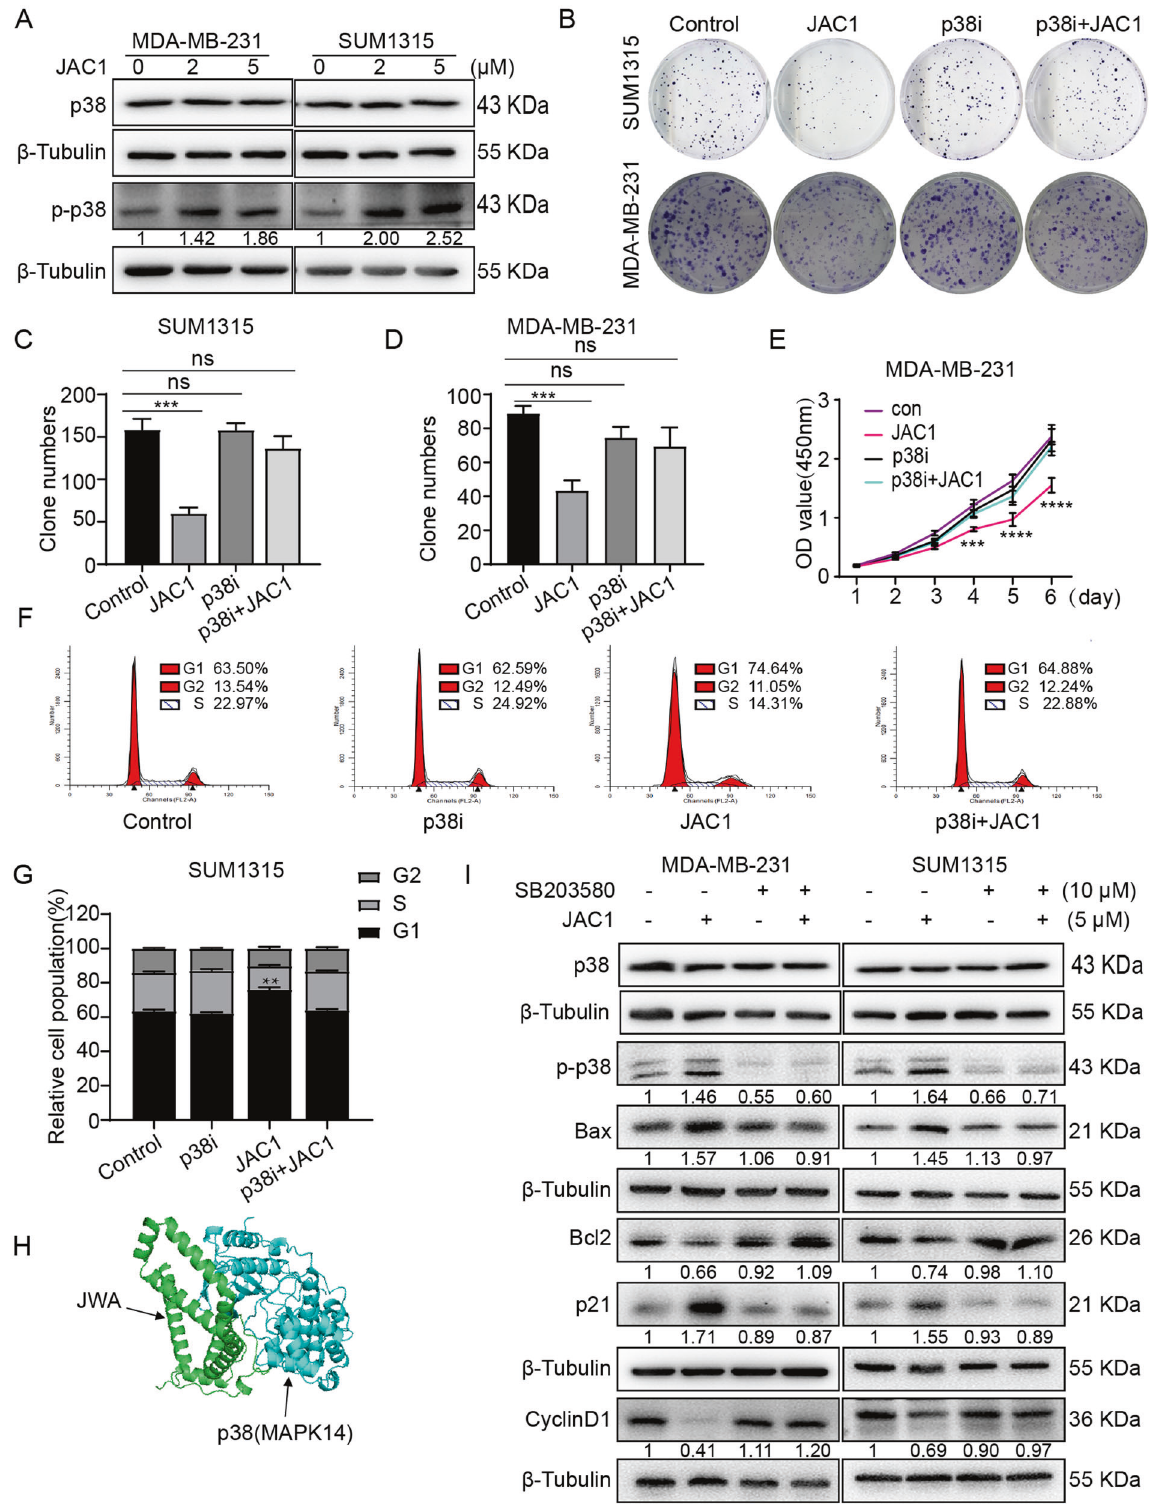
target cells, the small interfering RNAs of these six genes were constructed and transfected into cells, separately. As a result, only knocking down YY1 increased the expression of JWA (Supple- mentary Fig. 3C, D), and the other fi ve factors (CSDE1, LARP7, STAT1, p53, and ZFX) did not show obvious effects on JWA expression (Supplementary Fig. 3E –